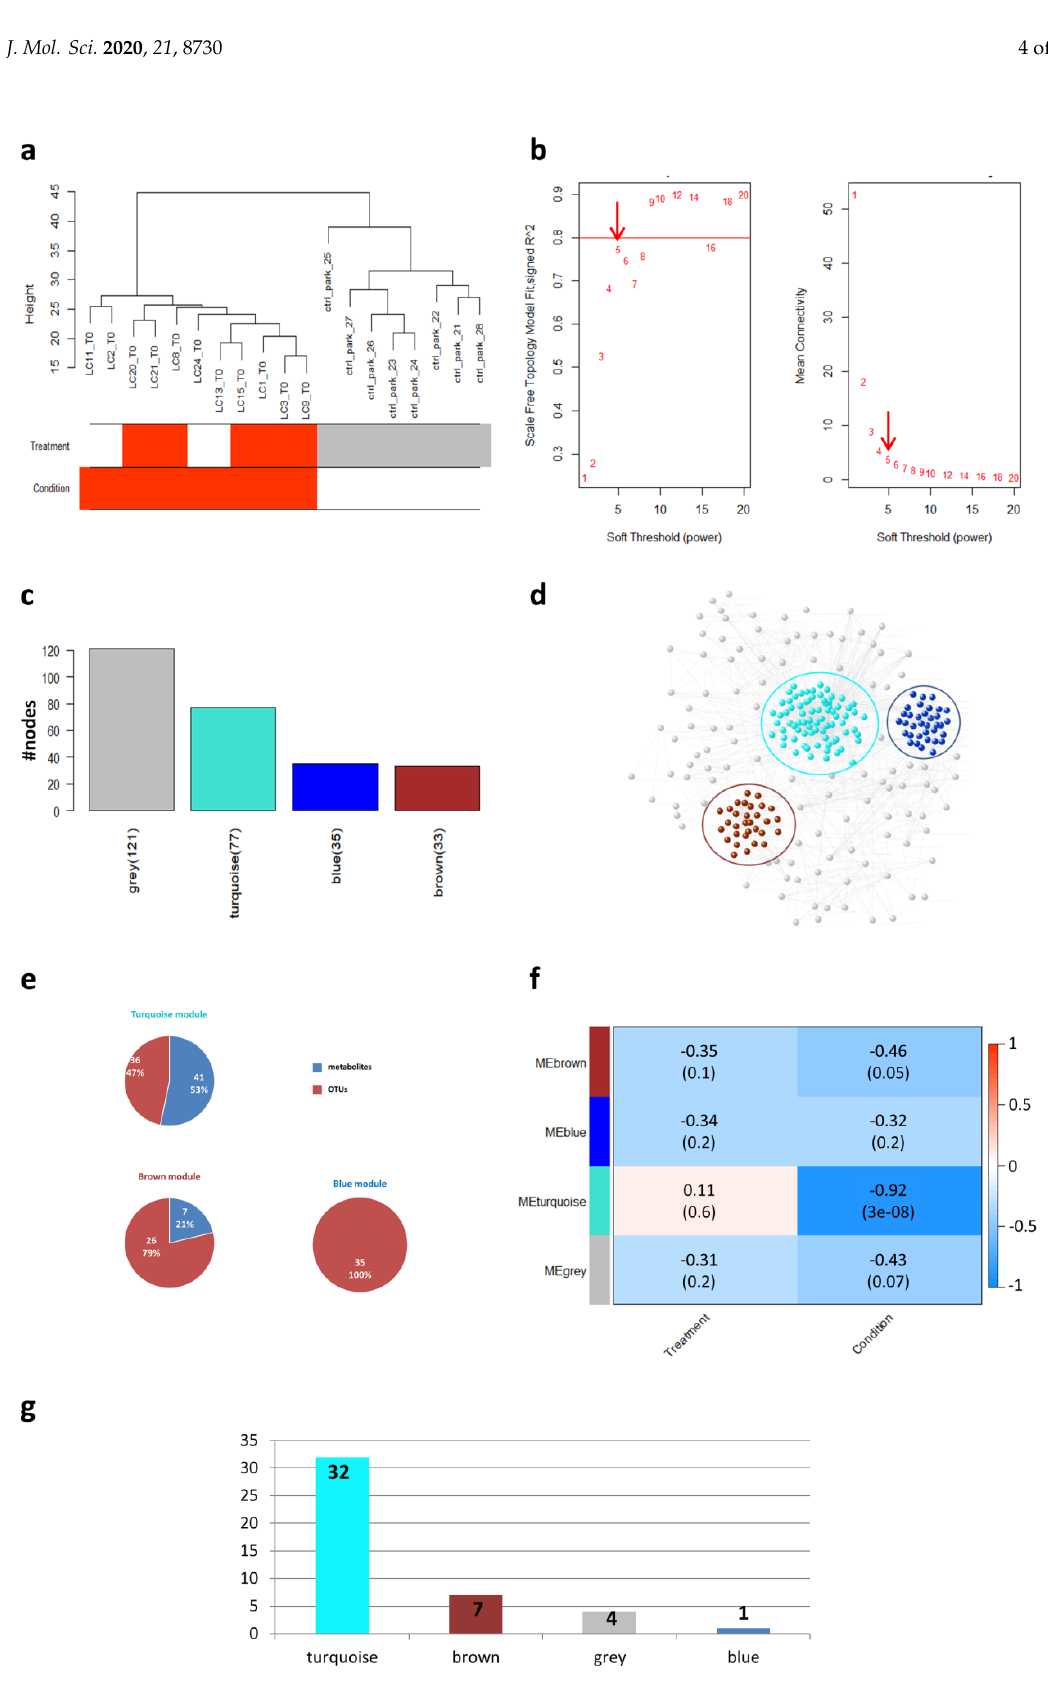
Figure 1. Weighted Gene Co-expression Network Analysis (WGCNA). ( a ) Clustering dendrogram of samples. Sample clustering was conducted to detect outliers. All samples were located in the clusters and passed the cut-off thresholds. The horizontal bars represent how the traits (i.e., condition and response to treatment) relate to the sample dendrogram: white (low value) represents controls (CTRLs) and non-responder (NR) for condition and treatment traits, respectively; red (high value) represents case and responder (R) for condition and treatment traits, respectively; gray means missing